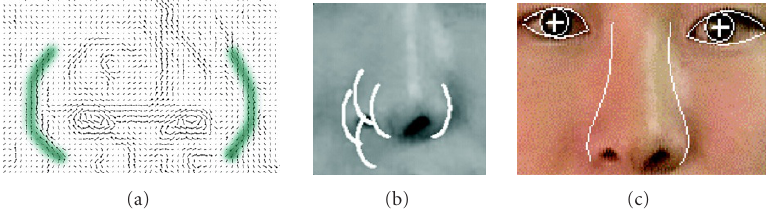
Figure 7: Nose contour detection. (a) Luminance gradient vector field of the nose area with nose-side parts marked. (b) Nose-side candi- dates. (c) Detected nose